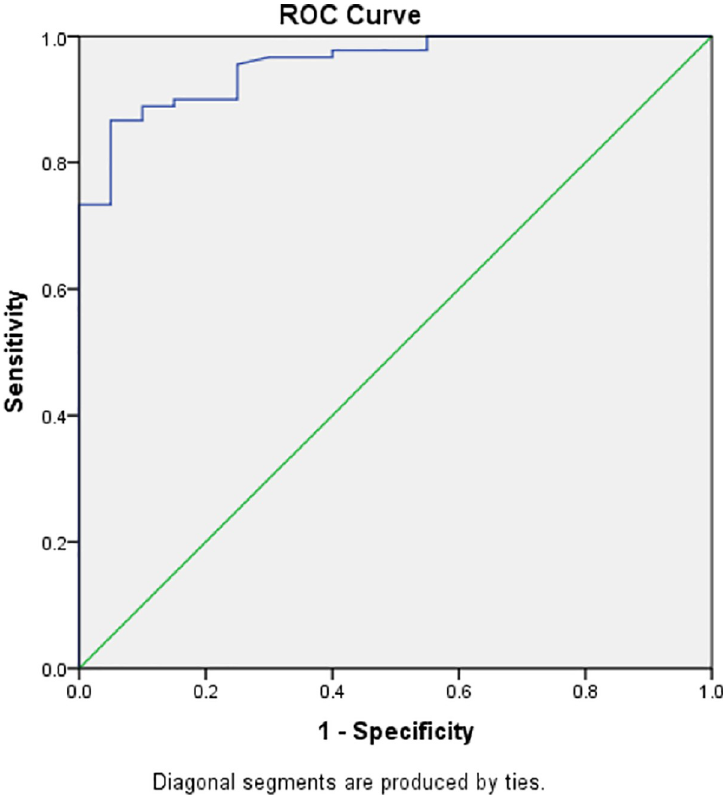
Fig 1. ROC curve of the two significant factors associated with having NAFLD. The area under the curve is 95.6% (95%CI: 91.9, 99.3).